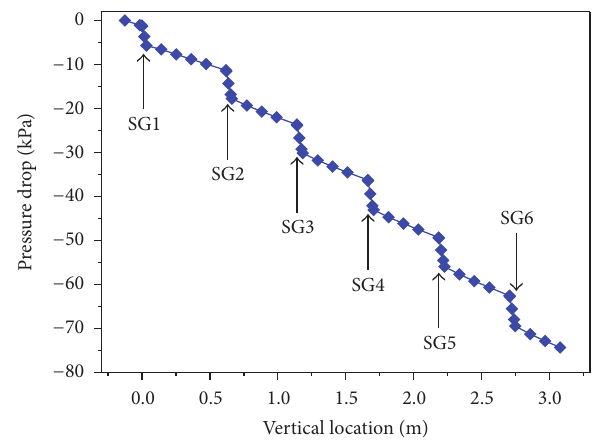
Figure 31: Pressure profiles along vertical